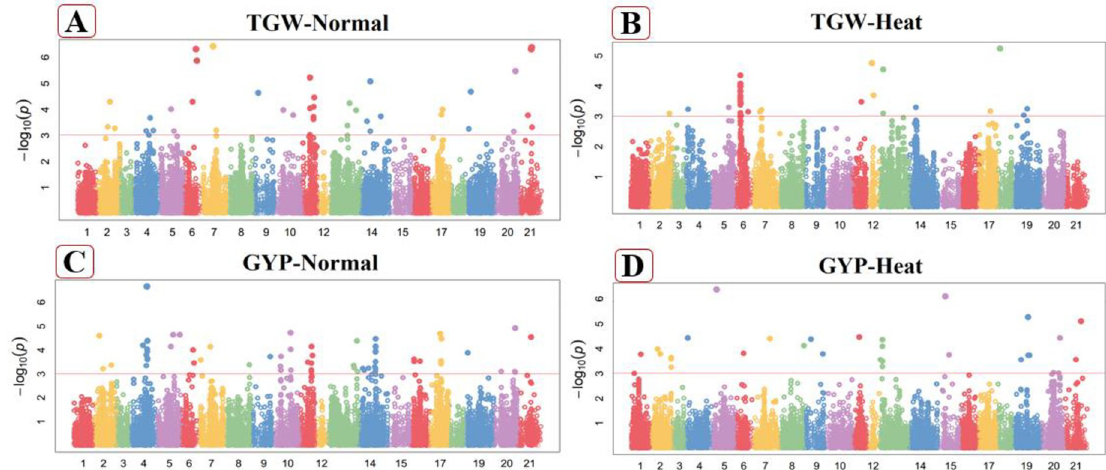
Fig 4. Manhattan plot of thousand grain weight (TGW) in normal ( A ), heat stressed ( B ) conditions and Gain yield per plant (GYP) in normal ( C ), heat stressed ( D ) conditions. These figures exhibiting the position of significant SNPs and -log10(p) linked with specific traits in normal and heat stressed